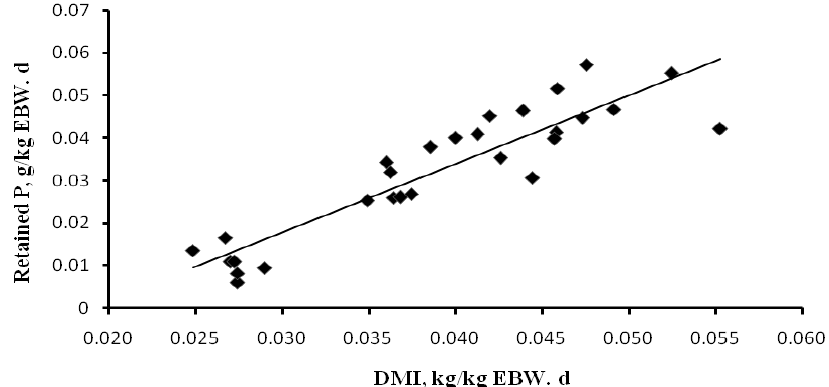
Figure 1. Relationship between retained P and DMI of Dorper  thin-tailed Han crossbred ram lambs. Retained P (g/kg EBW) = 1.607(  0.145)  DMI (kg/kg EBW)-0.030(  0.006) (RMSE = 0.006; p<0.0001; r 2 = 0.826; n =